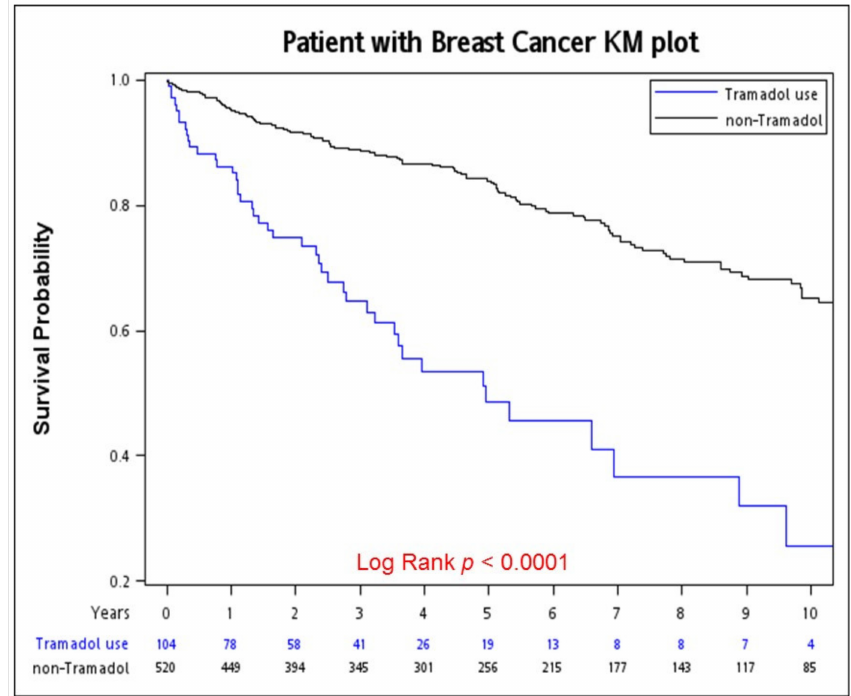
Figure 2. Kaplan–Meier overall survival curves of propensity scores matching chronic pain patients using tramadol or non-tramadol analgesic drugs before breast cancer